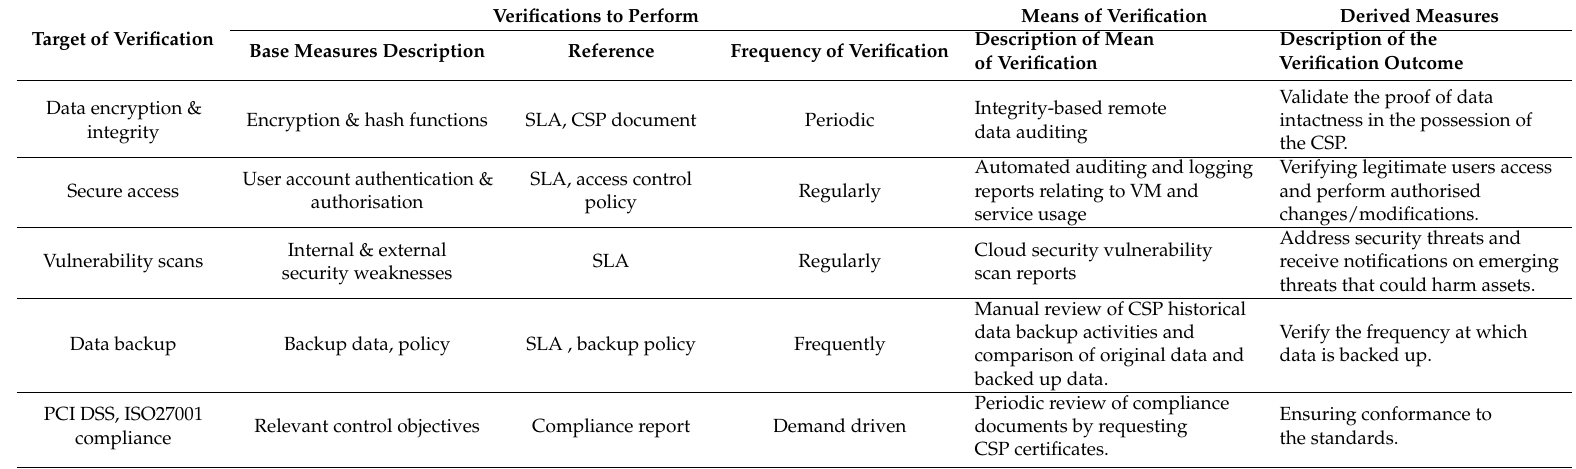
Table 4. Monitoring